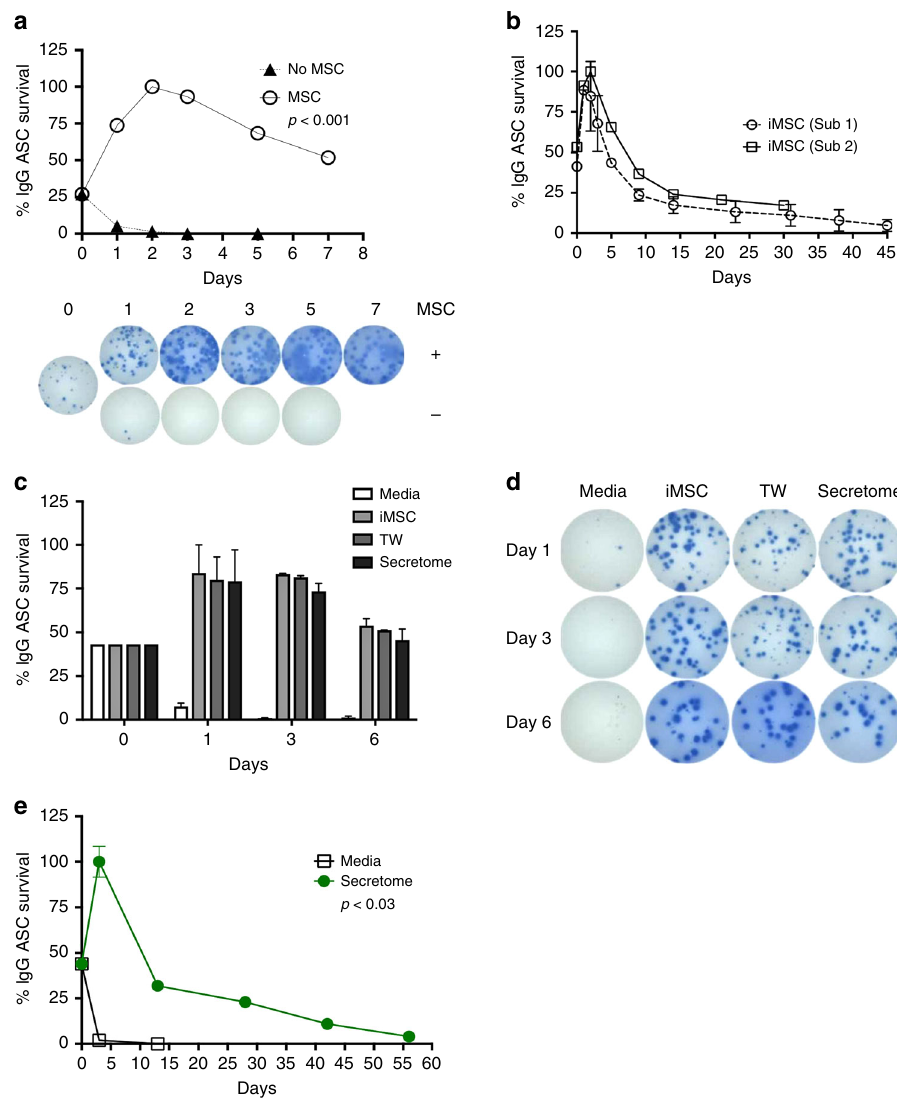
Fig. 1 BM-MSC support in vitro survival of blood ASC. a Short-term survival of blood ASC in irradiated MSC (iMSC) co-cultures. FACS puri fi ed blood ASC (1000/well) were cultured in RPMI with 10% FBS (R10) (No MSC) or co-cultured with 50,000 BM-MSC (MSC) for 7 days ( p < 0.001; ANOVA). Representative images of Elispot wells are shown. b Long-term survival of blood ASC and iMSC co-cultures from two different adult blood samples after vaccination. Five hundred to 1500 ASC with 25,000 or 30,000 iMSC were co-cultured in each well and IgG Elispots were performed on designated days. c , d Pro-survival support of BM-MSC is independent of cell – cell contact. Same number of blood ASC were cultured in R10 (Media), co-cultured with 50,000 iMSC (iMSC), in transwells with ASC and 50,000 iMSC in separate chambers (TW), or iMSC secretome (Secretome). Representative Elispot wells are shown in d . e Long-term survival of blood ASC in MSC secretome. One thousand ASC were cultured in MSC secretome or with media alone ( p < 0.03; linear regression modeling using media (secretome) as a covariate). In a – c , e , Elispot assays were performed on the indicated day and the